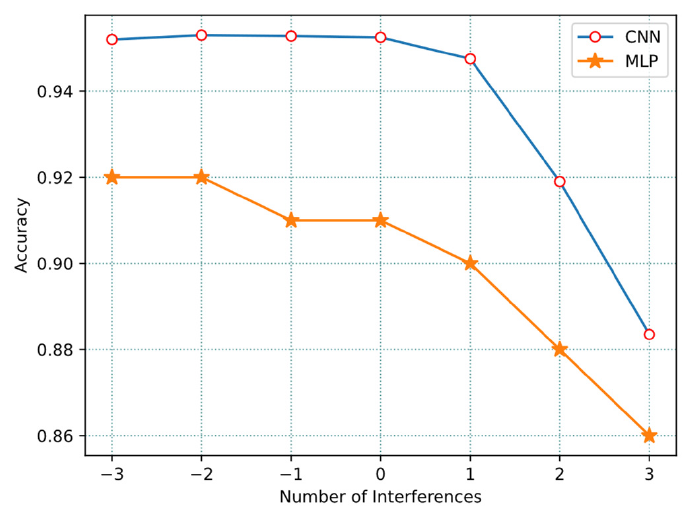
Figure 8. Classification result of samples with µ = 2.2.